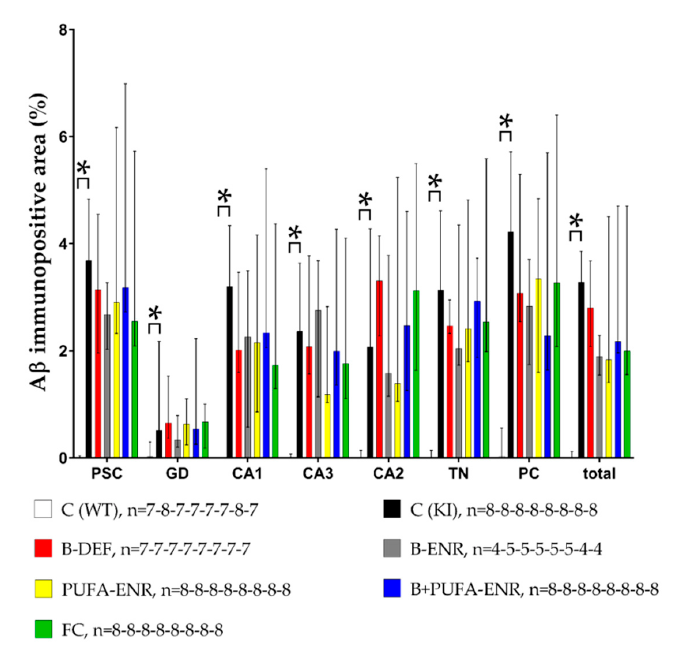
Figure 10. Immunohistochemically stained sections of mouse brains; regions of interest (ROI) in cortical and hippocampal areas are marked in whole brain images (100× magnification) and depicted separately for further semi-quantification of amyloid plaques; 35 weeks of age, 30 weeks on experimental diet. ( A ) Exemplary section of a C57BL/6J wild type animal. ( B ) Exemplary section of an App NL-G-F knock-in animal.